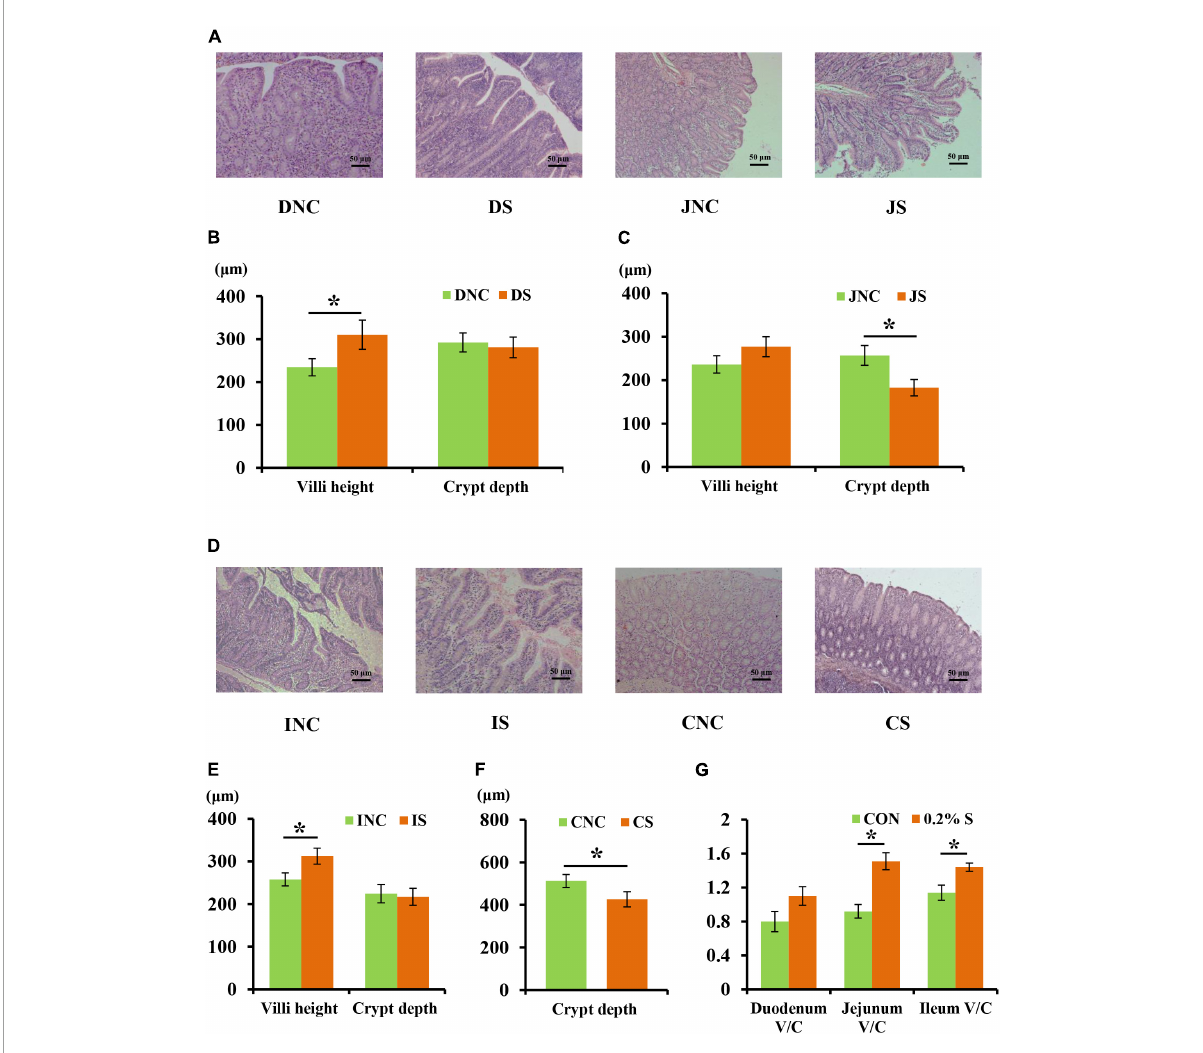
FIGURE1 Effects of 0.2% sodium butyrate on the small intestine and colon mucosal morphology. (A) Mucosal morphology of duodenum and jejunum from weaned piglets. (B) The changes of villus height and crypt depth of duodenum. (C) The changes of villus height and crypt depth of jejunum. (D) Mucosal morphology of the ileum and the colon from weaned piglets. (E) The changes of villus height and crypt depth of ileum. (F) The changes of crypt depth of colon. (G) The ratio of the villus height and crypt depth (V/C) of the duodenum, the jejunum, and the ileum. Values are means ± SEM, n = 6. * P < 0.05. DNC, duodenum negative control; DS, duodenum with 0.2% sodium butyrate; JNC, jejunum negative control; JS, jejunum with 0.2% sodium butyrate; INC, ileum negative control; IS, ileum with 0.2% sodium butyrate; CNC, colon negative control; CS, colon with 0.2% sodium